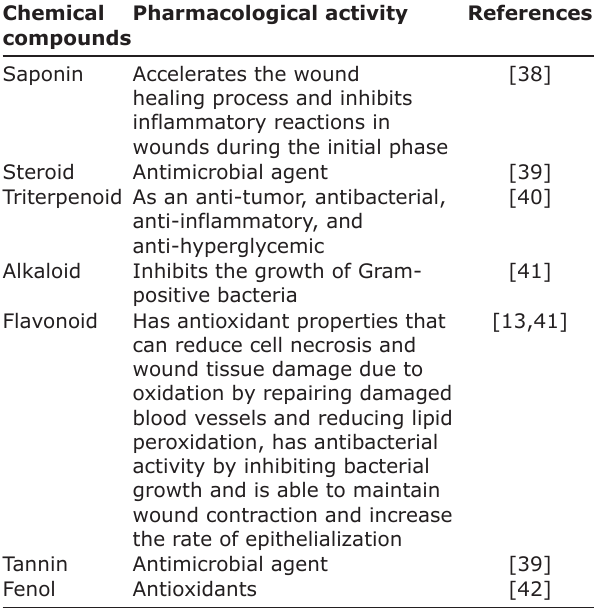
Table-2: Pharmacological activity of the active compound of U.